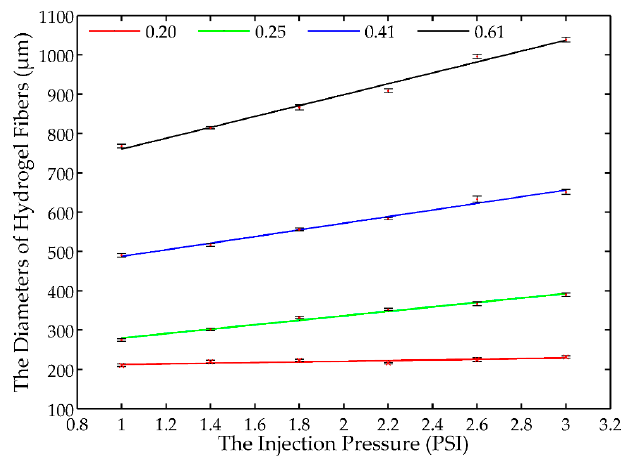
Figure 3. The measured diameters of the hydrogel fibers fabricated using four different nozzles and the corresponding linear fitting results with r -square values of 0.7, 0.991, 0.994, and 0.992, respectively.